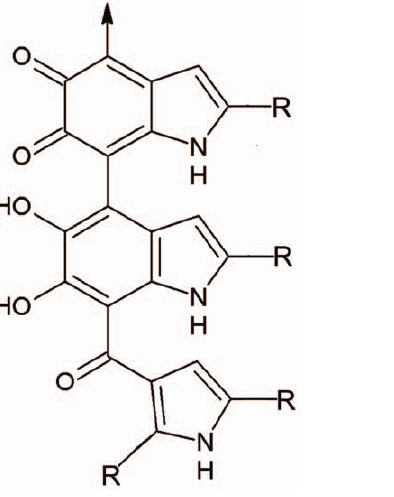
Figure 1. Structure of eumelanin oligomer, adapted from [ 11 ] . R=H, COOH, or other subunits.